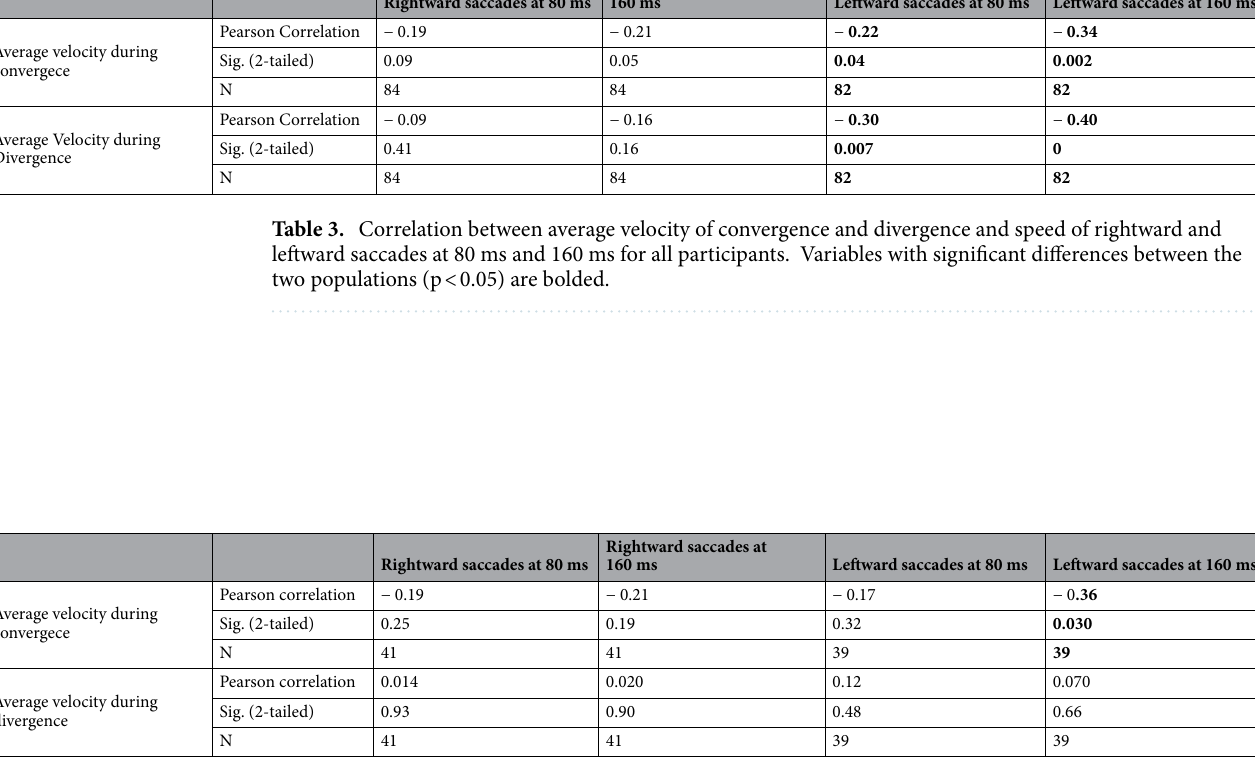
Table 4. Correlation between average velocity of convergence and divergence and speed of rightward and leftward saccades at 80 ms and 160 ms for dyslexic participants. Variables with significant differences between the two populations (p < 0.05) are